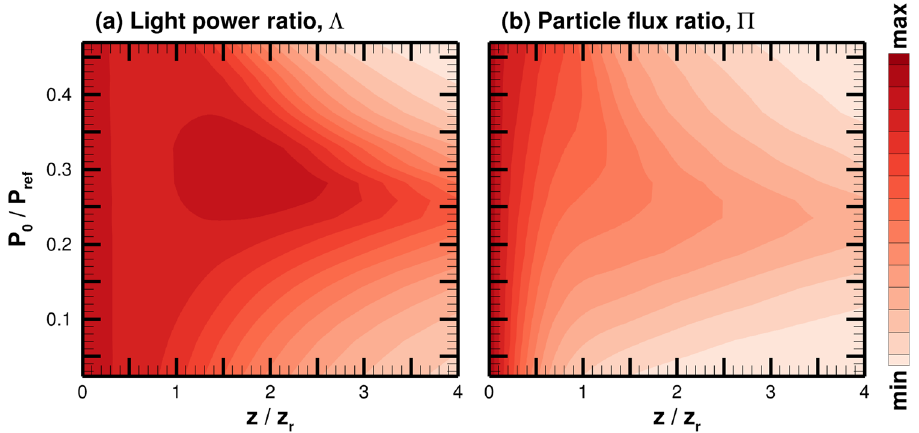
Figure 7. ( a ) Light power ratio and ( b ) particle flux ratio for a range of injected laser power. Min and max values correspond to 0.1 and 1.0, respectively. The injected power is normalized by P ref = 8.52